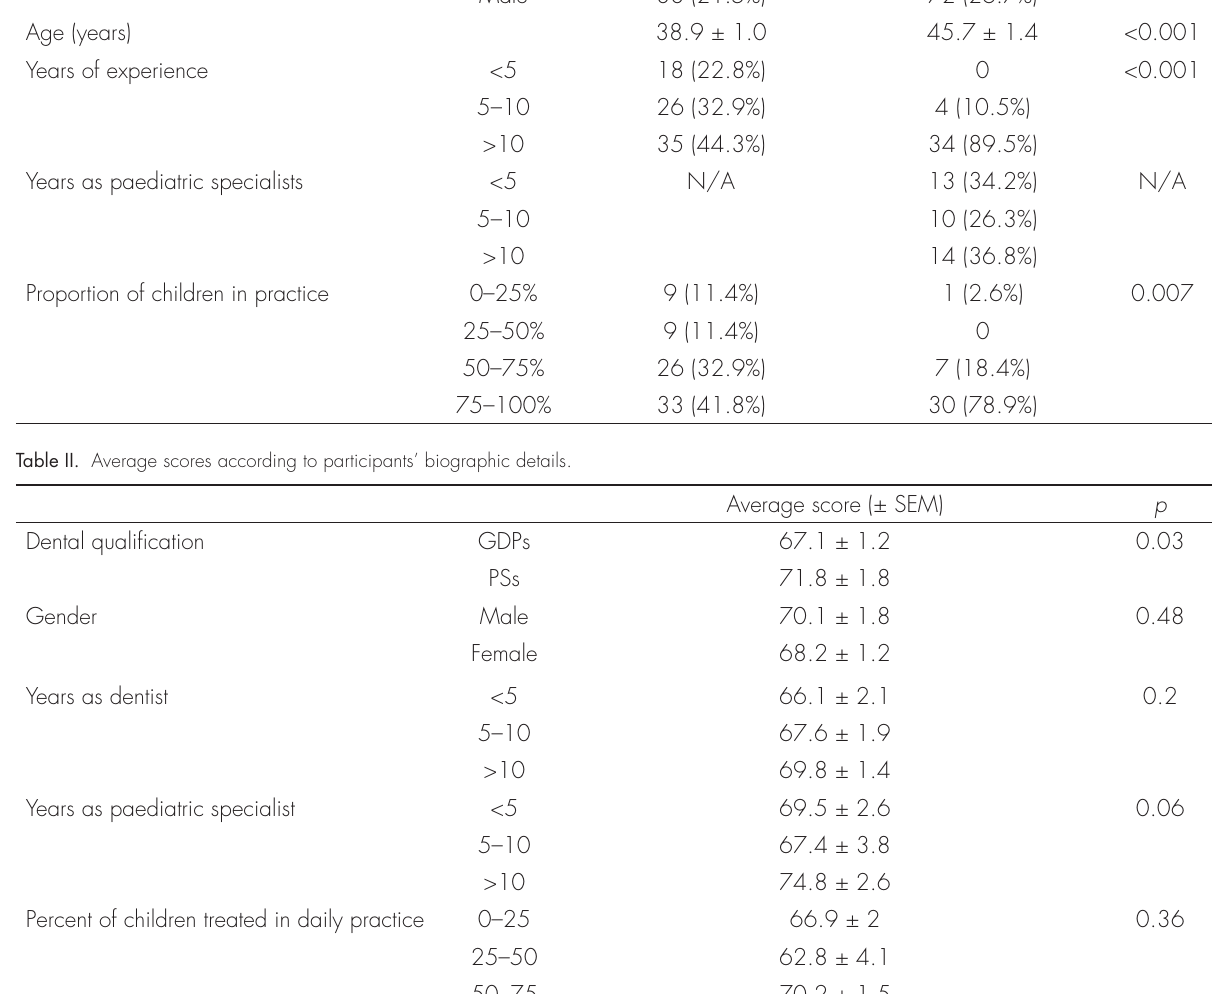
Data are presented as mean ± standard error of the mean. Statistical analyses were performed using the Mann-Whitney’s U test or Kruskal-Wallis test as